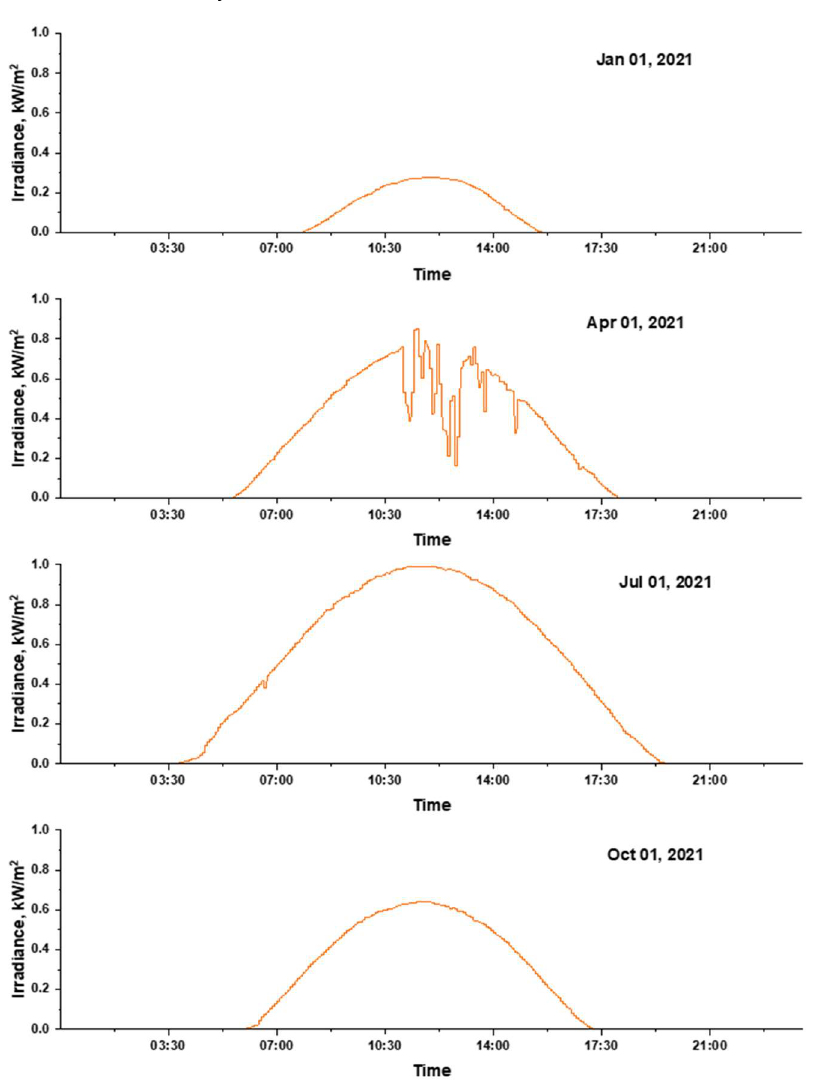
Figure 3. Daily measurements of solar irradiance for four selected days. Figure 5 shows the monthly and yearly averages for energy consumption, solar irradiance, and ambient temperature. The average monthly energy consumption was 925.47 kWh, which fluctuated from month to month, and the total annual energy consump- tion for the year 2021 was 11,237 kWh. The daily average solar irradiance was recorded at 4.6 kWh/m 2 /day, the highest in current solar irradiance due to the summer months (May–October) and the lowest during winter months (November–February). Spring and fall seasons have higher solar irradiance than winter. The annual average of the ambient temperature is 23.71 ◦ C, which is high during summer and low during